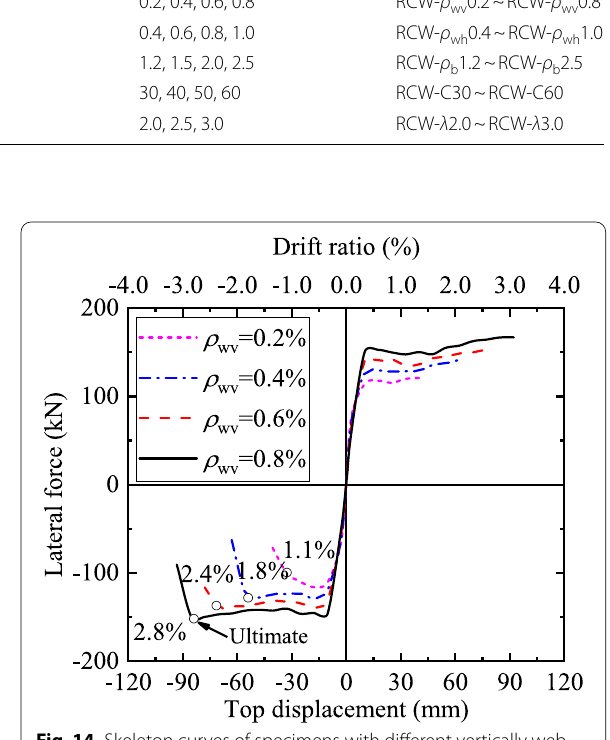
Fig. 14 Skeleton curves of specimens with different vertically web distributed